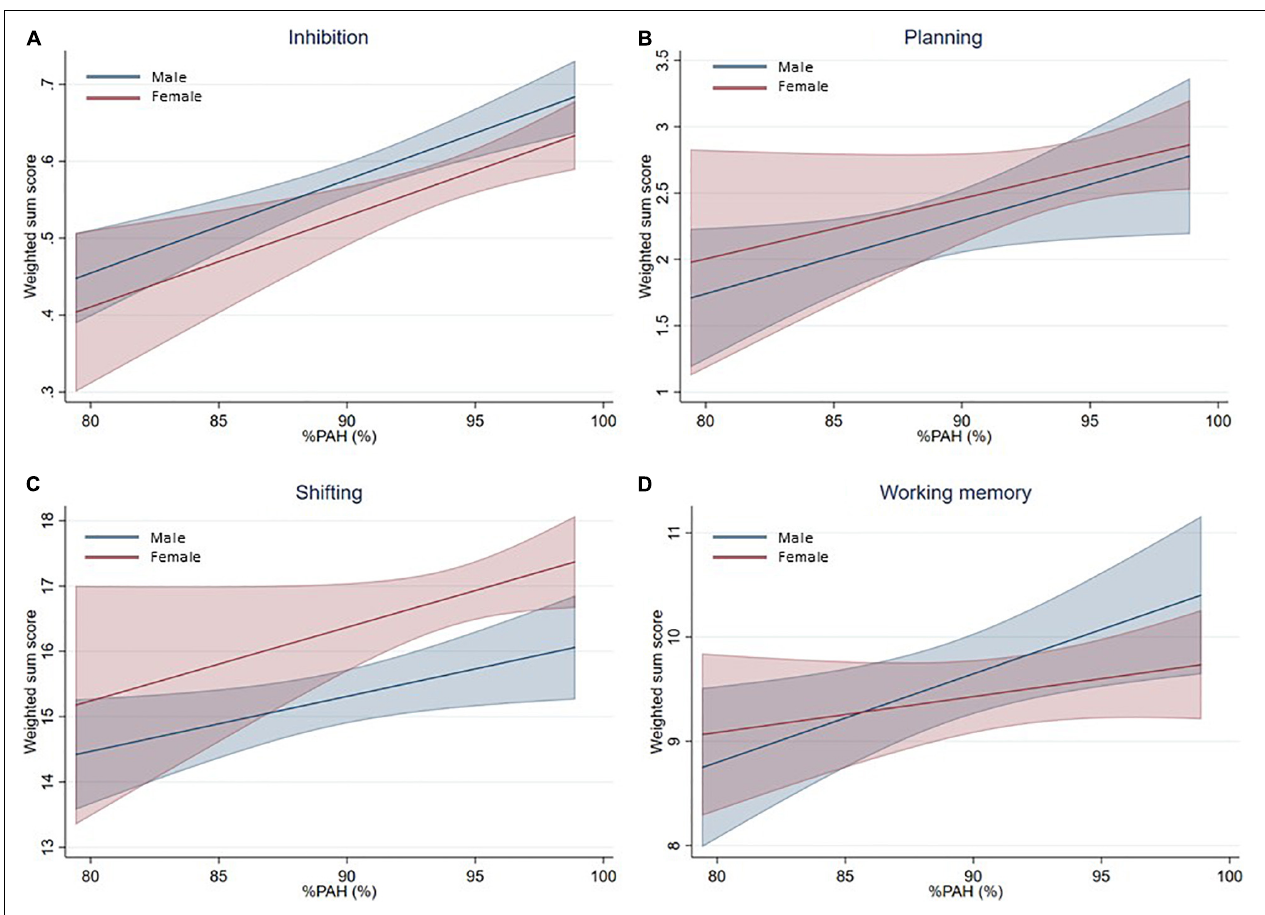
FIGURE 2 | Prediction plots of the means and standard deviations based on EEG model 2. Per EF component, a prediction of the mean with its standard deviation in relation to %PAH is made, based upon the weighted sum scores. Blue represents males, red females. %PAH, percentage of predicted adult height. (A) Inhibition. (B) Planning. (C) Shifting. (D) Working